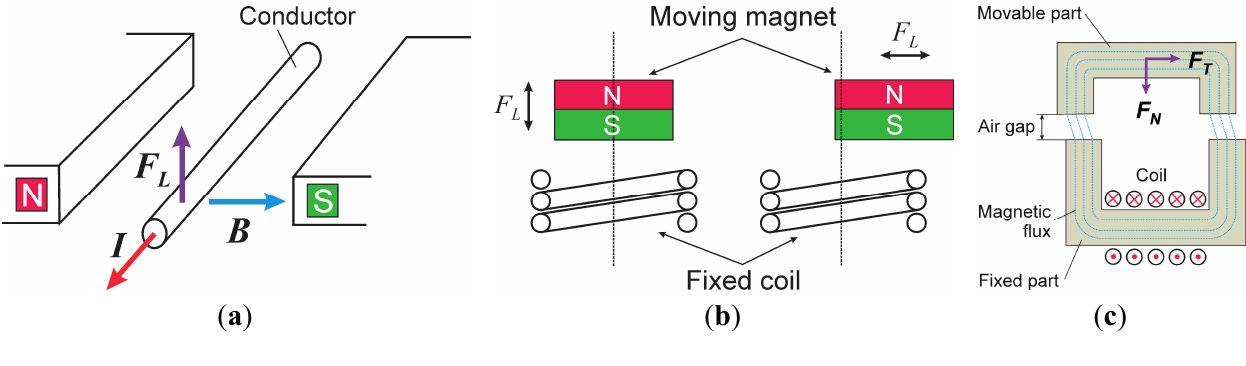
Figure 1. Magnetic actuation principles: ( a ) Lorentz force on current-carrying conductor; ( b ) moving magnet approach of permanent magnet excited motor; and ( c ) variable reluctance (VR)